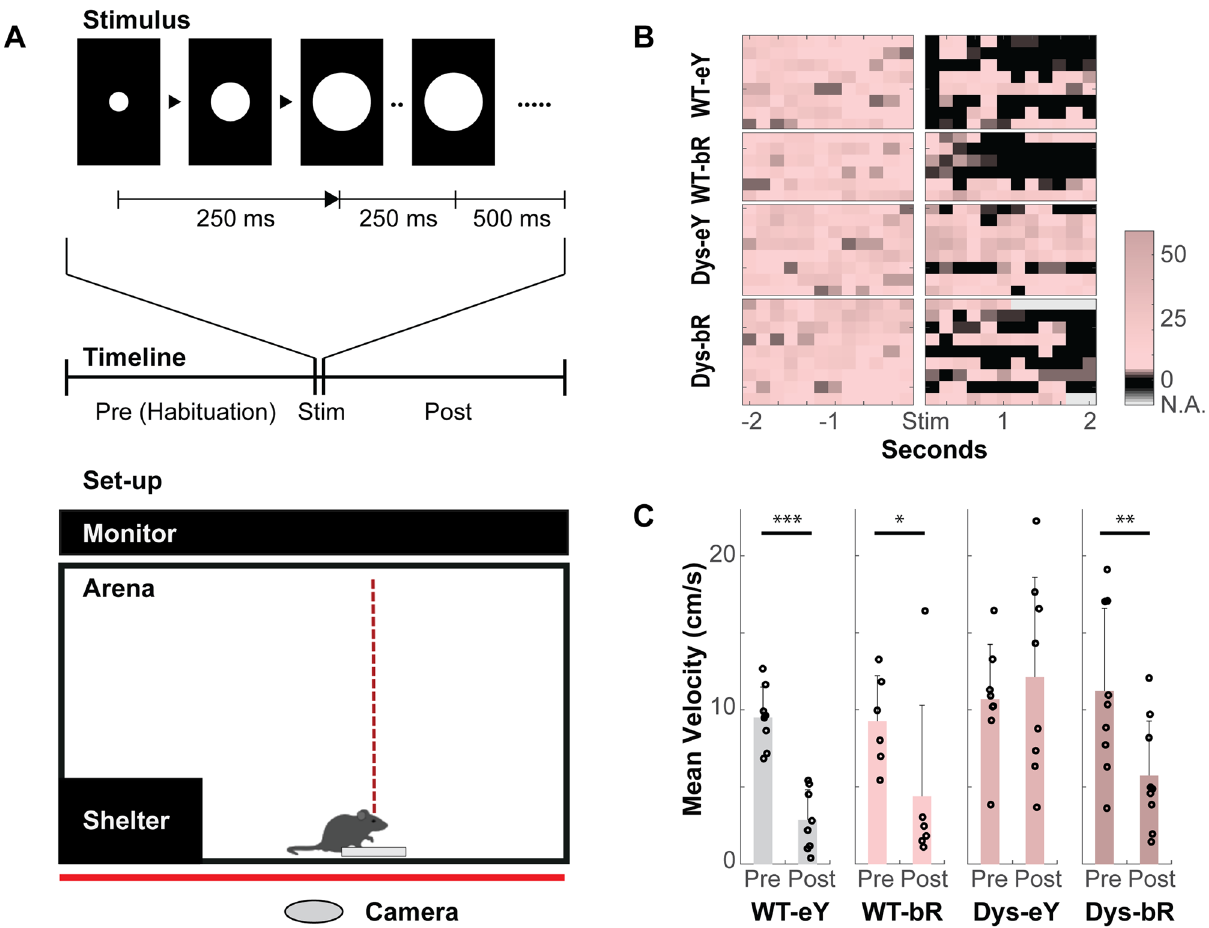
Figure 6. bReaChES restores visually-evoked responses in dystrophic mice. ( A ) Looming stimulus enclosure set-up. Individual mice are placed in an arena with a central dish and shelter placed in one corner. An LCD panel is positioned overhead to present stimuli. Behaviour is monitored and recorded from below using a video camera (see Methods). Top inset: schematic showing expanding stimulus presented overhead. Panels show cross-sectional images of "looming" disk. Timeline: time course of a single trial. After a period of habituation, subjects are presented with an expanding positive contrast disk (white disk (15.7 log photons cm −2 s −1 ) expanding at rate of 72°s −1 across 500 ms, with a subsequent maintenance of 500 ms (see Methods)). ( B ) Heat maps of individual mice showing instantaneous velocities 2 s before and after stimulus initiation. Note the arrest in movement (dark regions) exhibited by three of the four groups tested (WT-eYFP (WT-eY), WT-bReaChES (WT-bR), and Dys-bReaChES (Dys-bR)). ( C ) Mean velocities of movement 2 s before (pre) and 2 s after (post) stimulus onset. Dys-eYFP (Dys-eY) mice exhibited no detectable differences in motion. In contrast, Dys-bR subjects showed recovery of visually-evoked arrest. (N = 9 bReaChES-injected dys mice, N = 8 control-injected dys mice, N = 5 bReaChES-injected WT mice and N = 8 control-injected WT mice). Error bars indicate ± SD. * p < 0.05; ** p < 0.01; *** p < 0.001, one-way ANOVA with Bonferroni post hoc